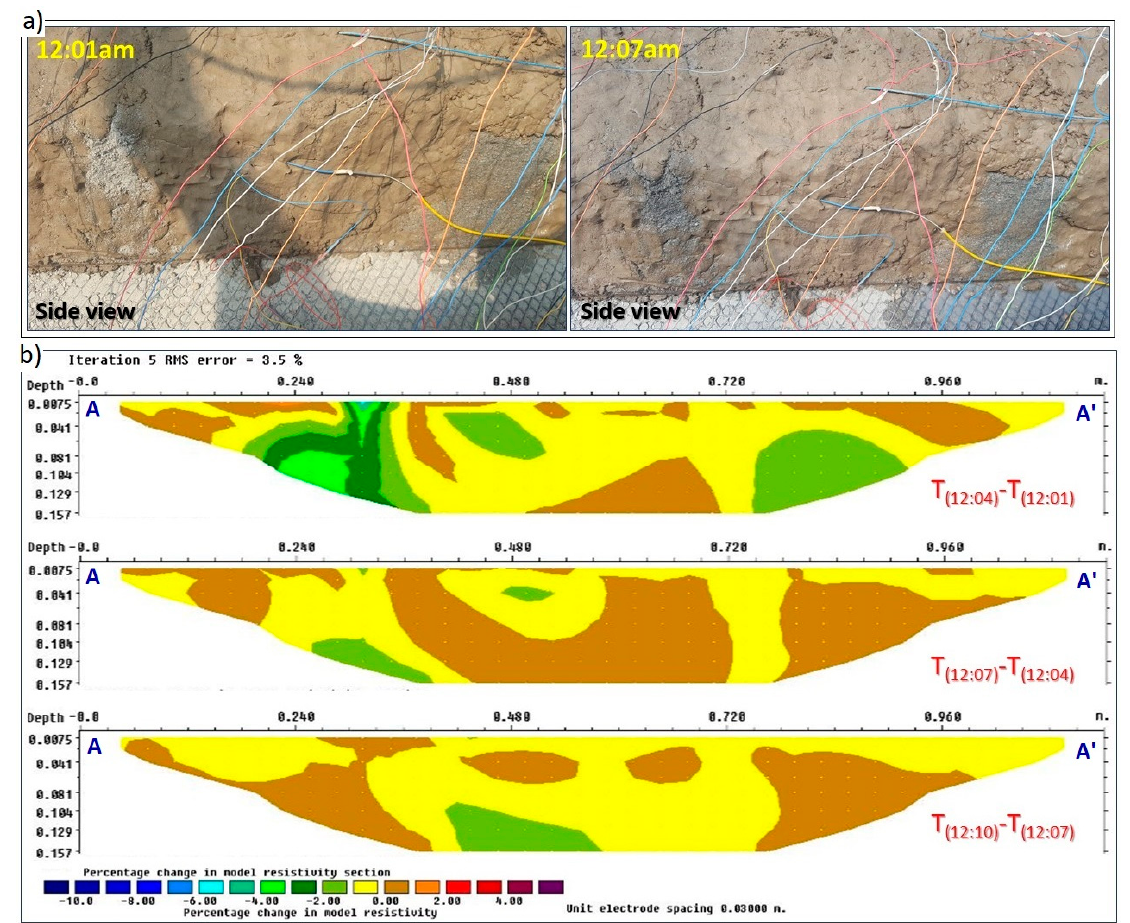
Figure 5. ( a ) Side views of the river levee at two times when the water is continuously exiting from the wider seepage zone on the right side of the levee (12:01 a.m.) and when the water is exiting from both seepage zones (12:07 a.m.). Light grey or